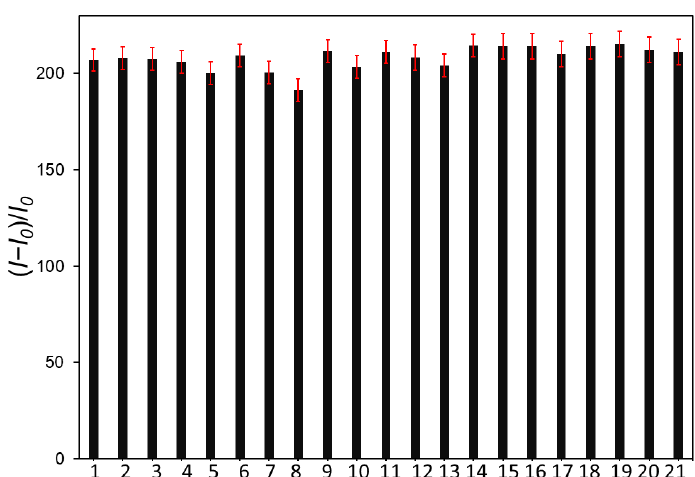
Figure 5. Bar plot showing relative fluorescence intensity change of APBI-Cu nanorods toward Na 2 S in presence of various competitive analytes (100 μ M) (1) no competitive analyte, (2) cysteine, (3) homocysteine, (4) glutathione, (5) NaF, (6) NaCl, (7) NaBr, (8) NaI, (9) NaNO 2 , (10) NaNO 3 , (11) NaHSO 3 , (12) Na 2 SO 3 , (13) Na 2 SO 4 , (14) NaHCO 3 , and (15) Na 3 PO 4 , (16) ethanol, (17) hexanol, (18) phenol, (19) acetic acid, (20) butanoic acid and (21) hexanal.